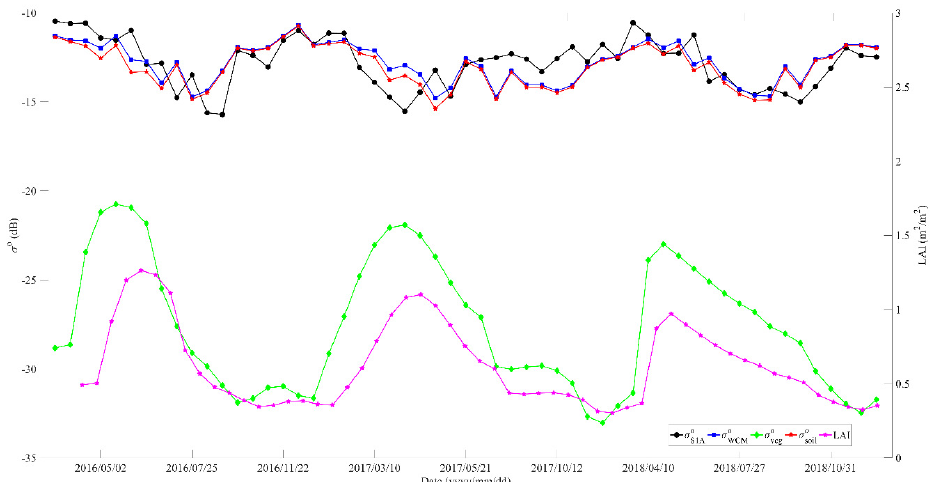
Figure 7. Time series of Sentinel-1A backscatter and WCM simulation. The 𝜎 (cid:3020)(cid:2869)(cid:3002)(cid:3042) , 𝜎 (cid:3024)(cid:3004)(cid:3014)(cid:3042) , 𝜎 (cid:3049)(cid:3032)(cid:3034)(cid:3042) , 𝜎 (cid:3046)(cid:3042)(cid:3036)(cid:3039)(cid:3042) , and LAI stand for the Sentinel-1A backscatter, WCM simulated total backscatter, vegetation scattering, soil scattering, and LAI, respectively.